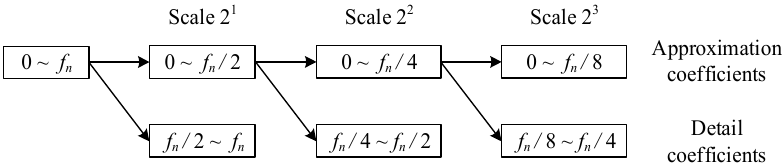
Figure 3. Multi-resolution Analysis by Dyadic wavelet transform (DWT).